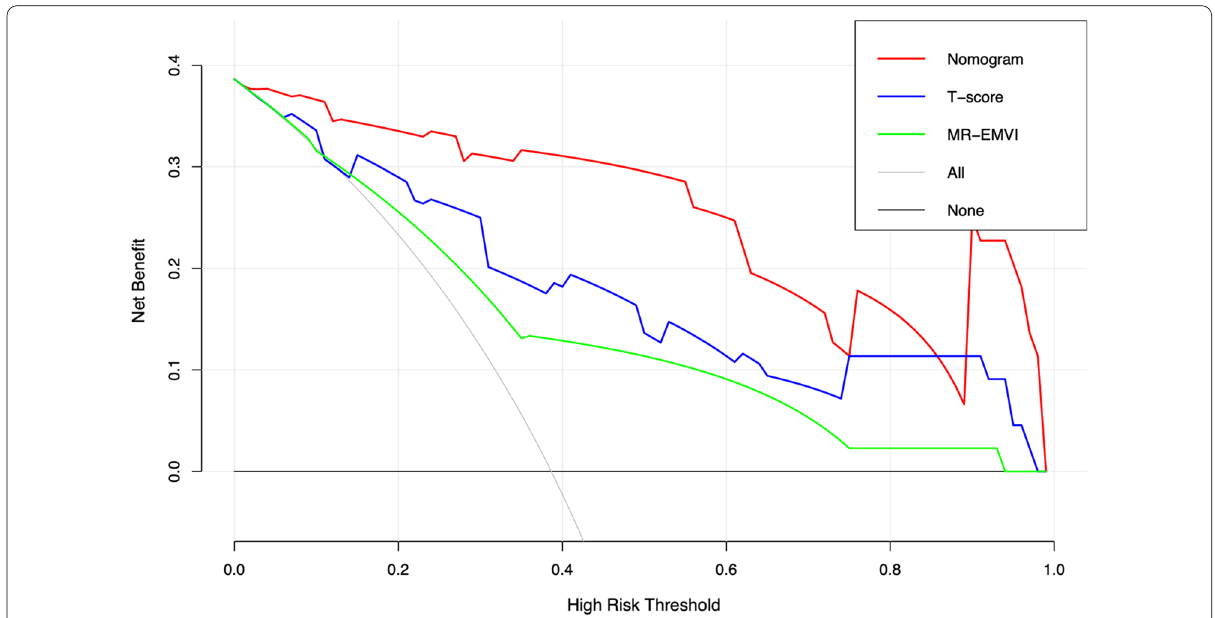
Fig. 6 Decision curve analysis for MR-EMVI, T-score and the nomogram of the EMVI assessment model. The black solid horizontal line at the level with Standardized Net Benefit 0 represents the assumption of all rectal cancer patients without EMVI. The grey solid line represents the assumption of all patients with EMVI. The green solid line represents the assumption that patients will be judged EMVI-positive if the positive probability obtained from MR-EMVI is higher than the threshold probability. The blue solid line represents the assumption that patients will be judged EMVI-positive if the positive probability obtained from T-score is higher than the threshold probability. The red solid line represents the assumption that patients will be judged EMVI-positive if the positive probability obtained from the nomogram is higher than the threshold probability. The decision curves showed that when the threshold probability is in a reasonable range, the nomogram provided the greatest net benefit when compared with the treat-all-patients approach, treat-none approach, and the MR-EMVI and T-score for predicting EMVI status of patients with rectal